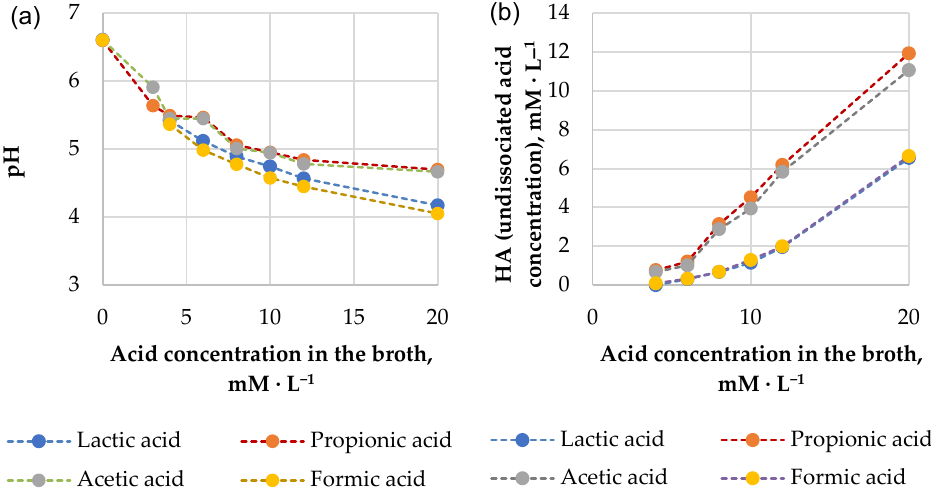
Figure 3. The relationship between the molar concentration of the acid and the pH of the medium ( a ) and undissociated acid concentration ( b ) in broth from the experiment of MIC s determination. It can be seen (Figure 3b) that the concentration of undissociated formic acid and lactic acid in the broths was about two times lower than the concentration of undissociated